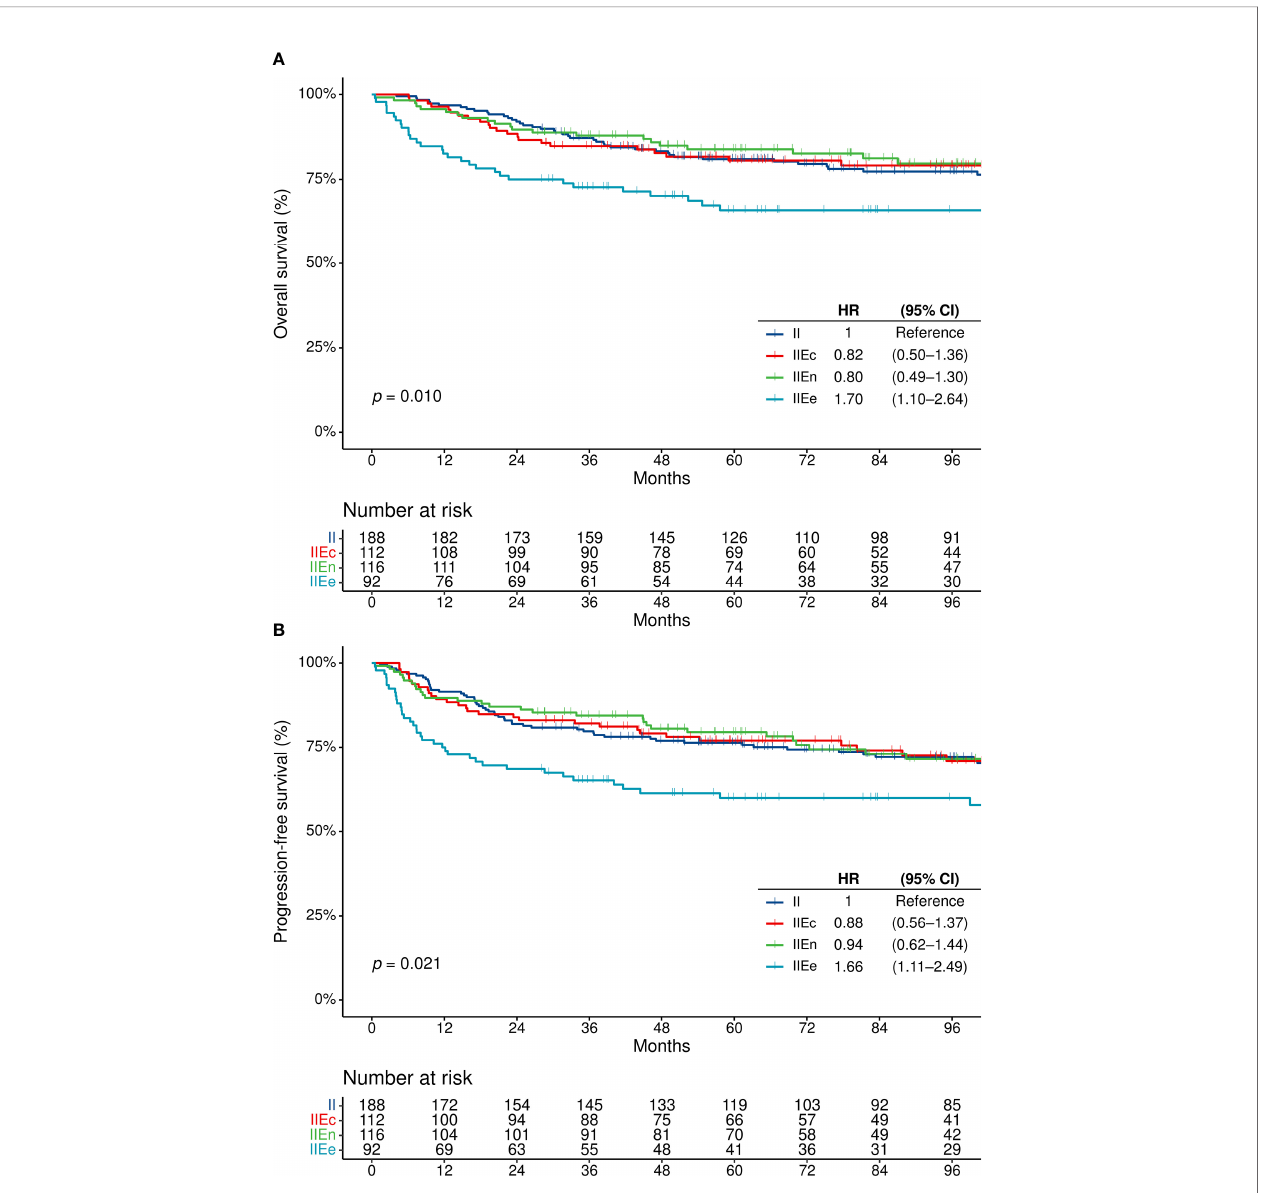
FIGURE 2 | Survival outcomes in patients with disease on the same side of the diaphragm. (A) Overall survival, and (B) progression-free survival. CI, con fi dence interval; HR, hazard ratio; OS, overall survival; PFS, progression-free